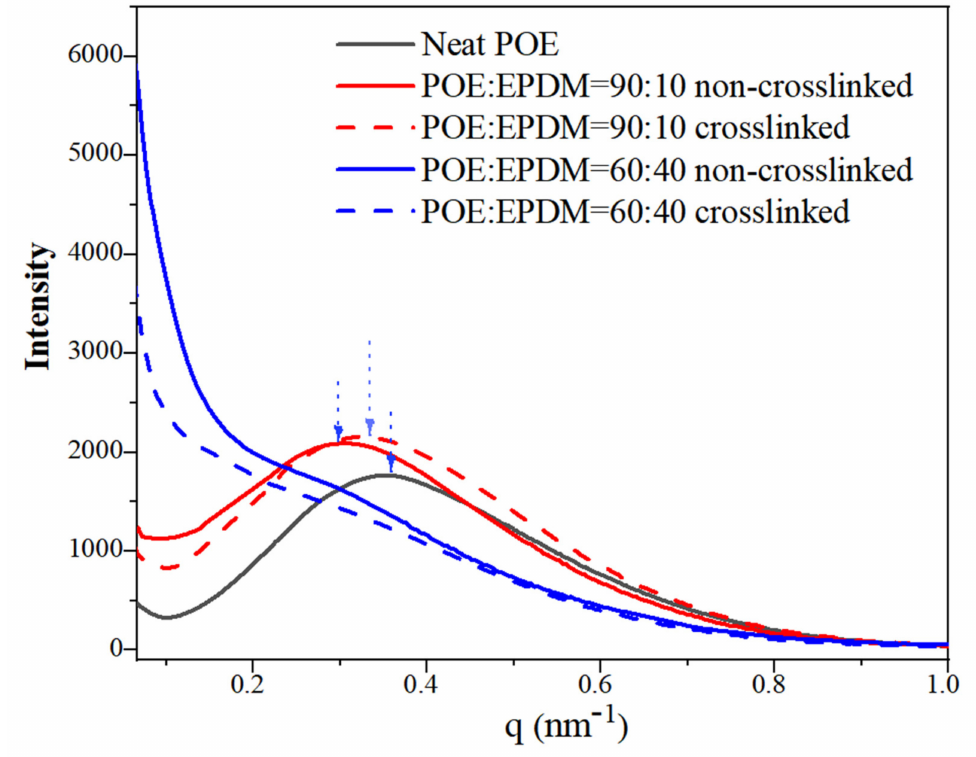
Figure 3. Linear SAXS profiles of neat POE and POE/EPDM blends: neat POE (black line), POE:EPDM = 60:40 non-crosslinked (blue line), POE:EPDM = 60:40 crosslinked (blue dotted line), POE:EPDM = 90:10 non-crosslinked (red line), POE:EPDM = 90:10 crosslinked (red dotted